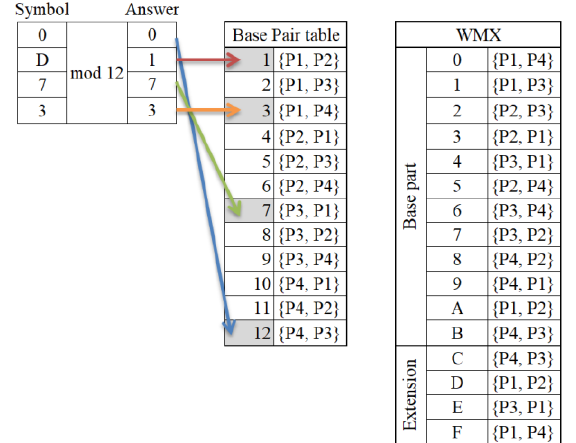
Figure 4. The example of textual information presentation: a) original text, b) barcode presentation, c) shrunk barcode (basic method), d) shrunk barcode after Arnold transform (15 iterations), e) linear interpretation of barcode (proposed method), f) linear interpretation after Arnold transform (use of secret key). Figure 5. The example of WMX basis formation for key “SecretKey” and frequency domain HH 2 .